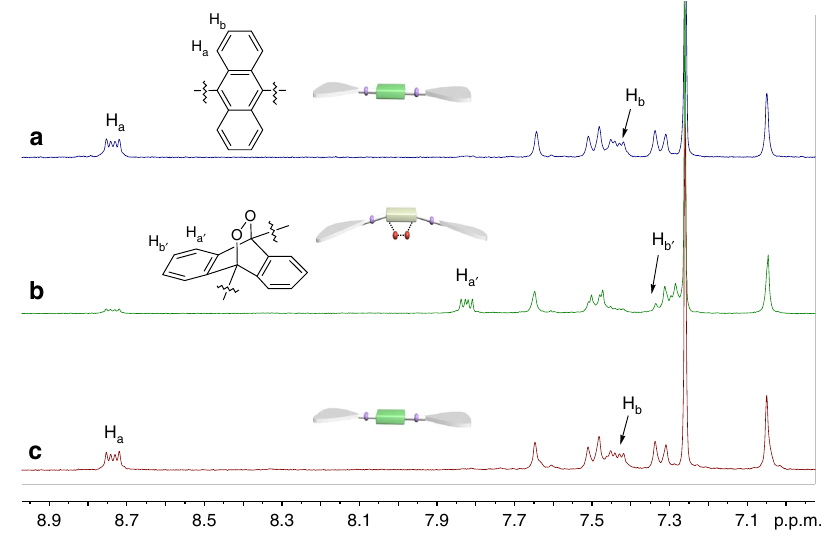
Fig. 5 Anthracene ‒ endoperoxide photo-switching of 1 . Partial 1 H NMR spectra (CDCl 3 , 298 K, 2.00 mM) of 1 : a before irradiation, b conversion to 1 -O 2 after 5 min irradiation, and c recovery to 1 upon room temperature standing for 10